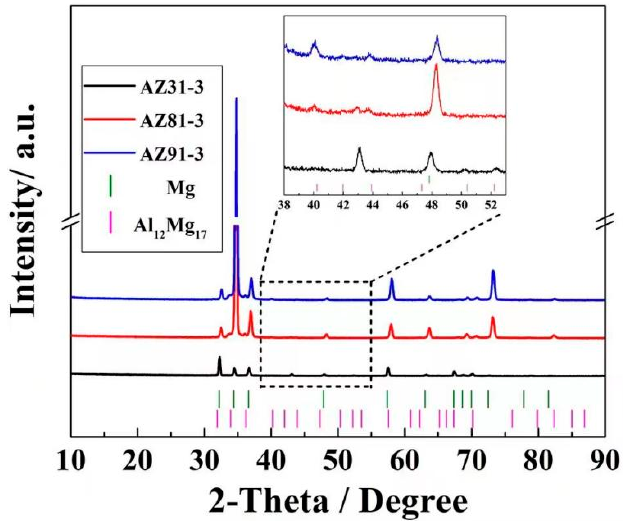
Figure 3. X-ray diffraction spectra of three as-extruded Mg alloy sheets in center area.